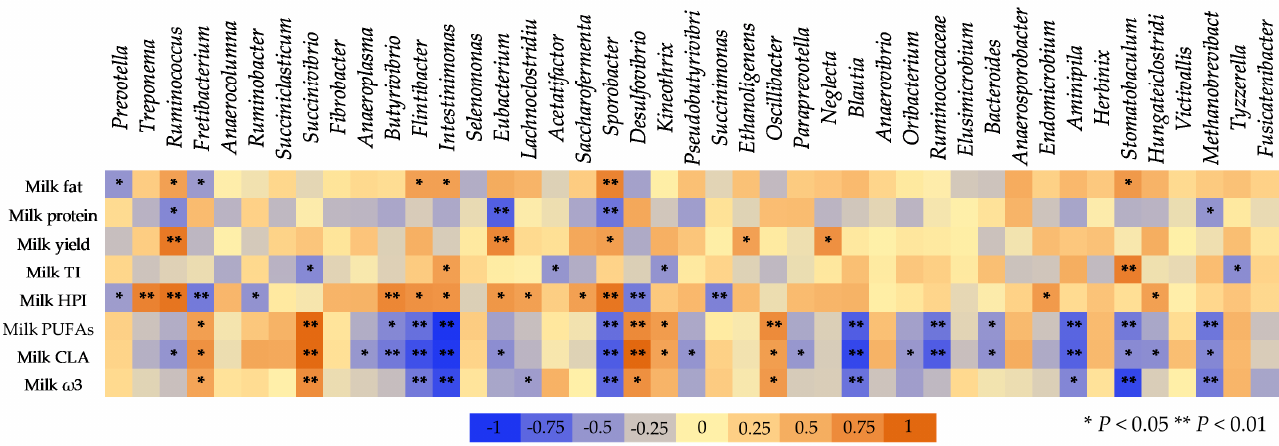
Figure 9. Spearman’s correlation between the most abundant genera within the goats’ rumen and milk performance and its important constituents. Milk fat expressed as percentage, milk protein expressed as percentage, milk yield expressed as ml/day; milk TI (thrombogenic index) = (C14:0 + C16:0 + C18:0)/(0.5 × MUFA) + (0.5 × ω 6 PUFA) + (3 × ω 3 PUFA) + ( ω 3 PUFA/ ω 6 PUFA); milk HPI (health-promoting index) = ( ω 6 PUFA + ω 3 PUFA + MUFA)/(C12:0 + 4 × C14:0 + C16:0); Milk PUFAs (polyunsaturated fatty acids) = cis-9, trans-11 C18:2 + C18:2n − 6c + C18:2n − 6t + C18:3n − 3 + C18:3n − 6 + C20:3n − 3; milk CLA (cis-9, trans-11 C18:2); and milk ω 3—the sum of C18:3n − 3, C20:3n − 3, and C22:6n − 3.